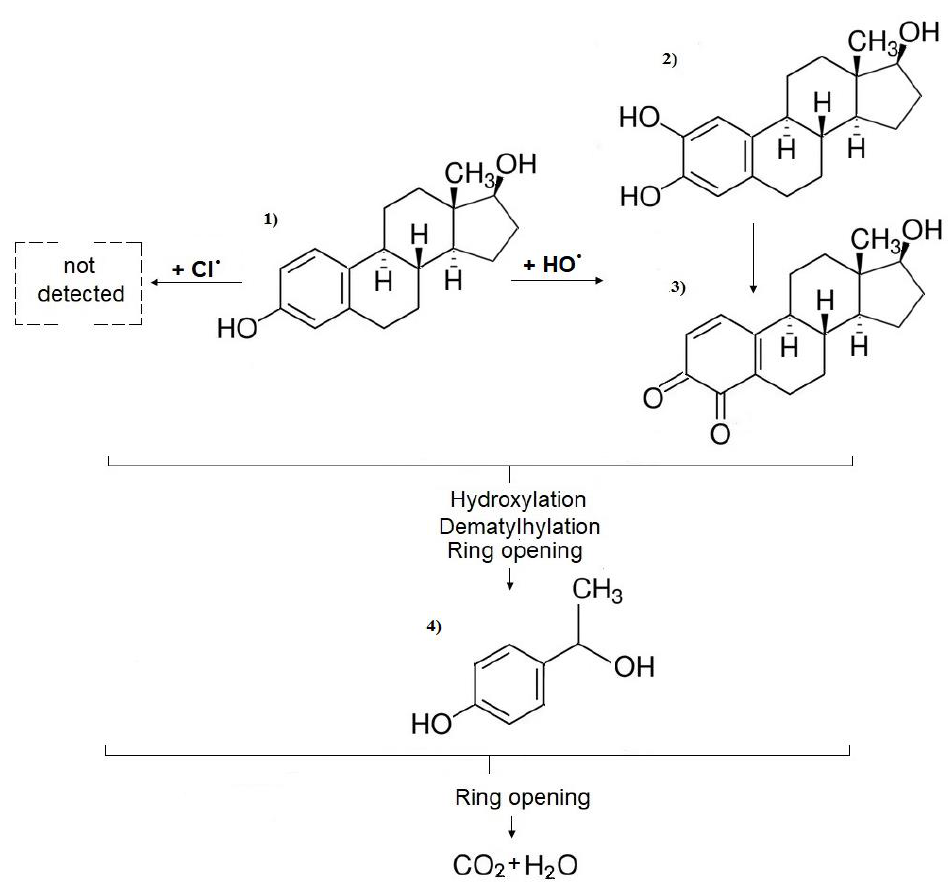
Figure 8. Possible decomposition of ( 1 ) IBU with the identified intermediates, ( 2 ) 2-Hydroxyestradiol, ( 3 ) Estradiol-3,4-quinone, and ( 4 ) 4-(1-Hydroxyethyl)phenol.